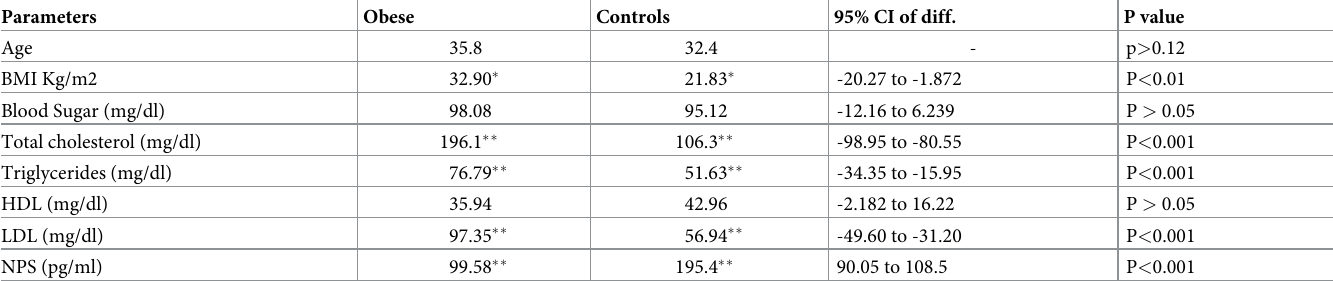
Table 1. Anthropometric and lipid profile of